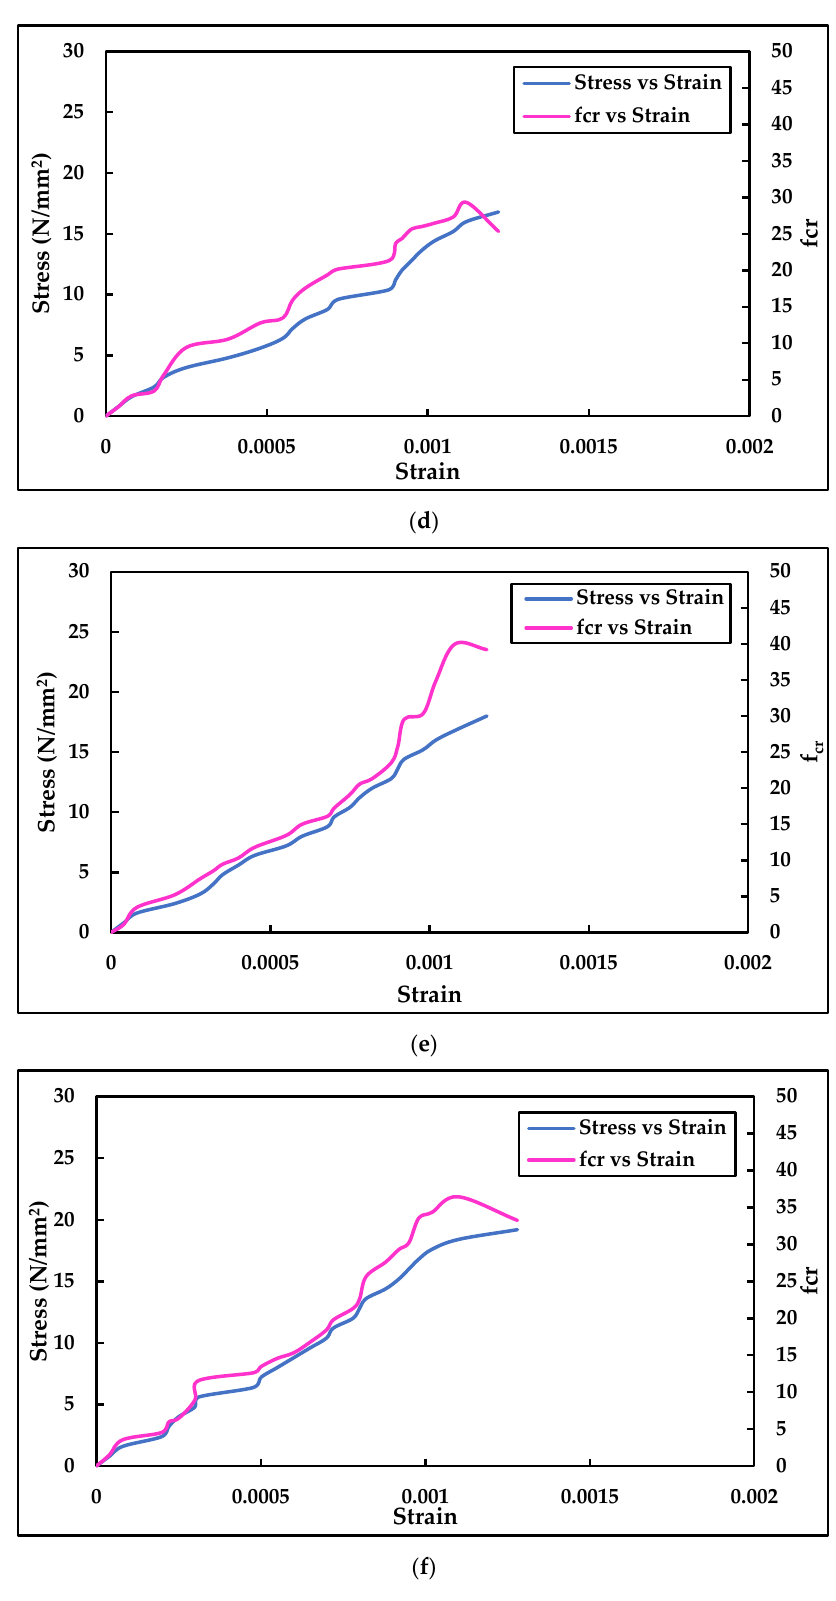
Figure 10. Graphical illustration of stress vs. strain and f cr vs. strain under 28 days of water curing. ( a ) Conventional mortar cube; ( b ) 0.10% brass fibre added mortar cube; ( c ) 0.15% brass fibre added mortar cube; ( d ) 0.20% brass fibre added mortar; ( e ) 0.25% brass fibre added mortar cube; ( f ) 0.30% brass fibre added mortar